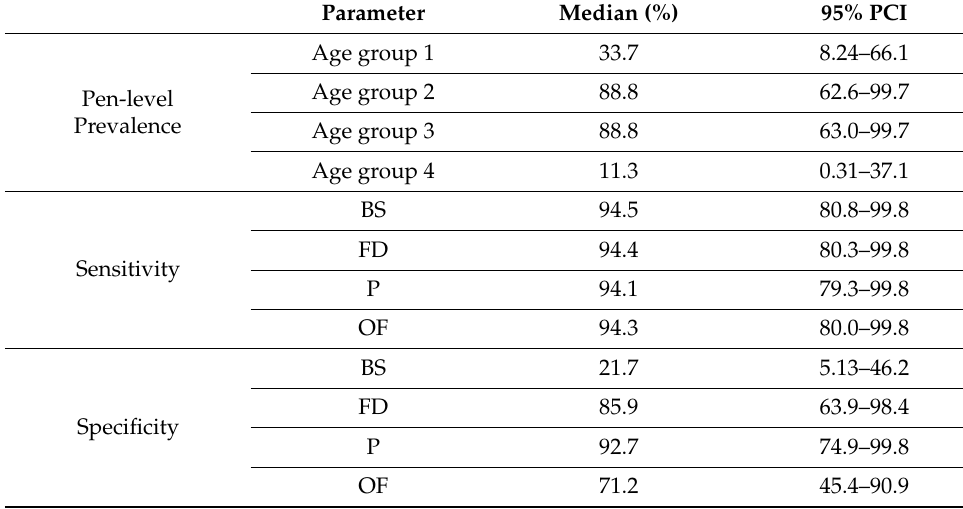
Table 2. Posterior estimation of sensitivity, specificity of four pen ‐ level sampling methods and of prevalence per age group, according to a Bayesian LCA with minimally informative priors and con ‐ ditional independence between sampling methods (PCI = posterior credibility interval, BS = boot sock, FD = faecal dropping, P = pool of individual rectal swabs, OF = oral fluid).